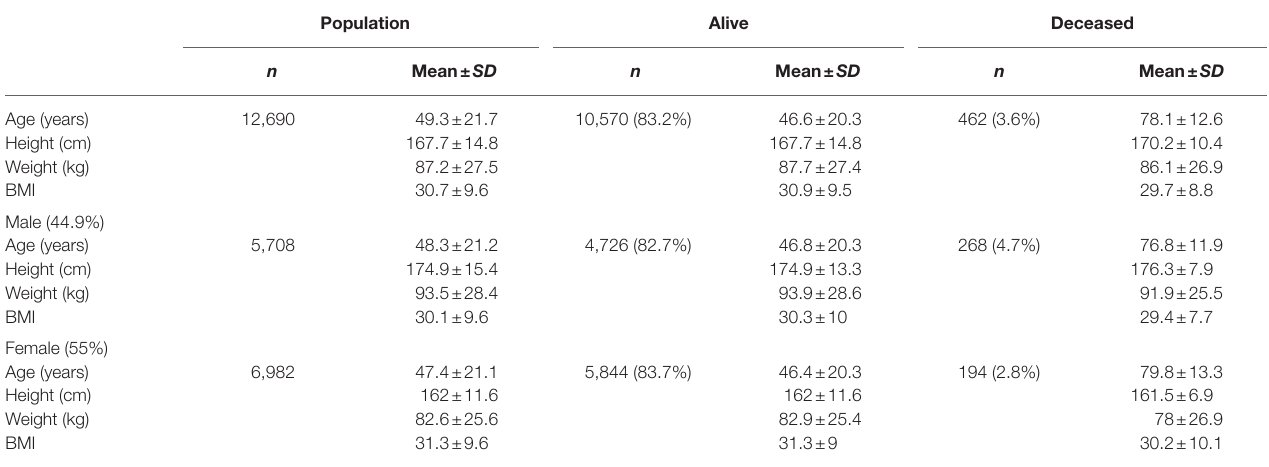
TABLE 1 | Demographic characteristics of sample population. Population